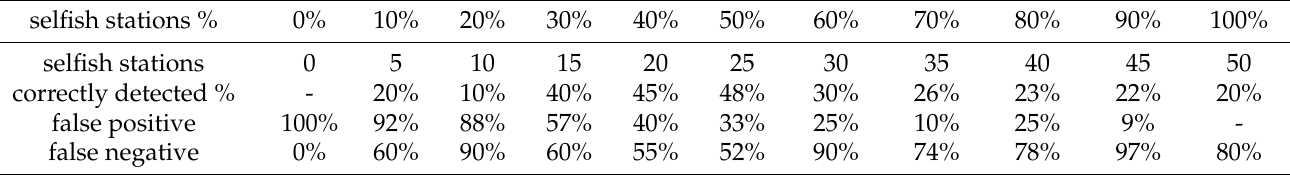
Table 7. Deviation detection mechanism for 50 stations and 2 slots in TCP IP camera